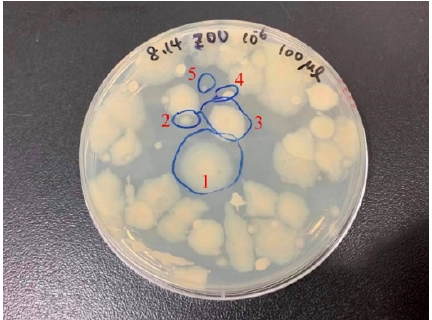
Figure 1. Colony morphology of Zuoying inocula on the marine broth agar.